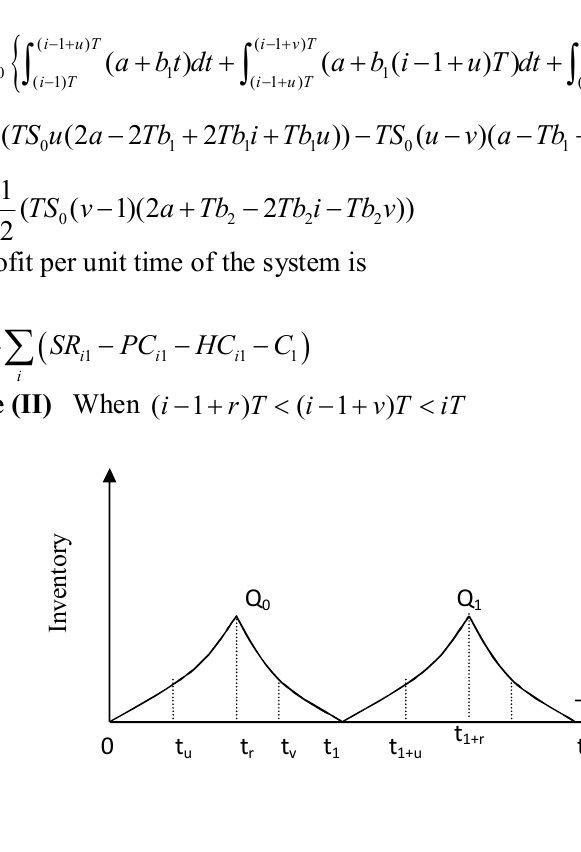
Fig. 2. Graphical representation of the system for Case